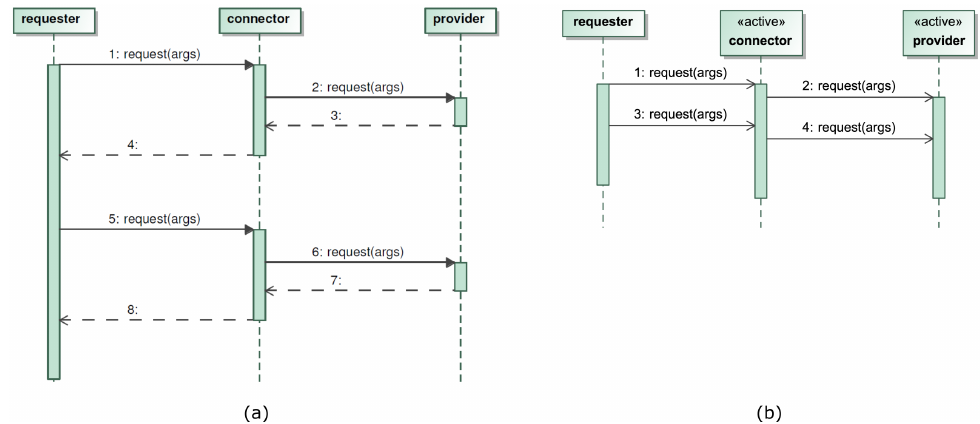
Figure 24. Synchronous and asynchronous handling of requests using enhanced connectors: ( a ) Synchronous handling of requests using enhanced connectors. ( b ) Asynchronous handling of requests using enhanced